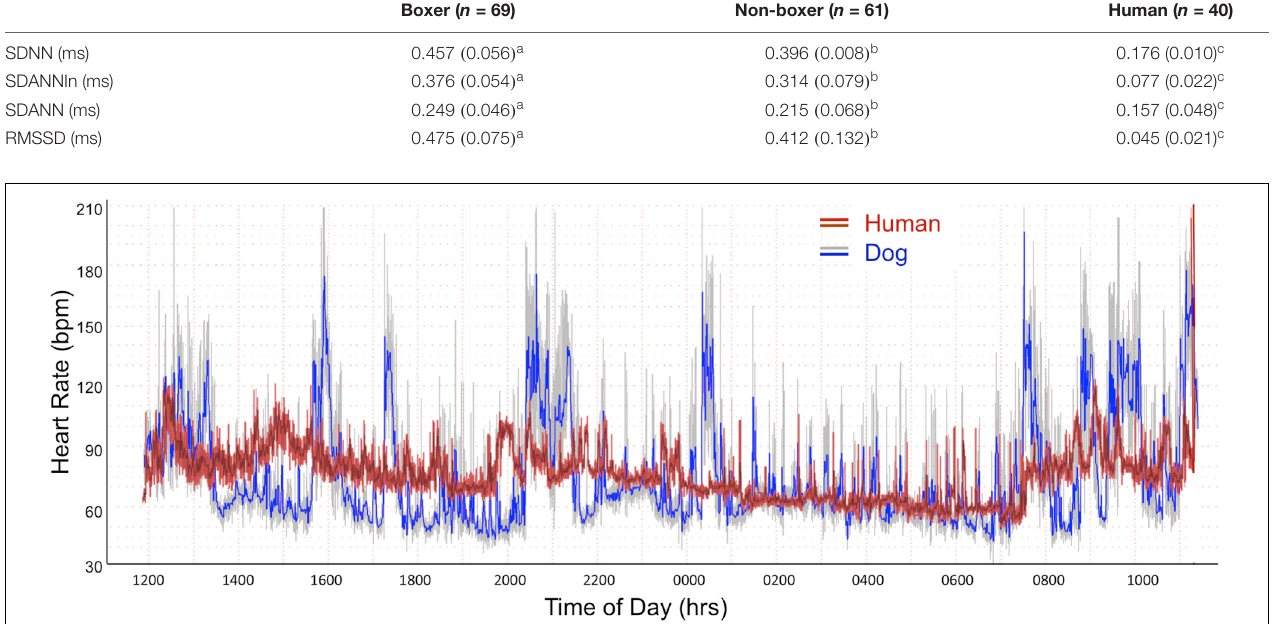
(RMSSD). The frequency domain parameters analyzed were total power and high frequency. For the frequency domain analyses a window of 512 beats with a Hamming filter applied was